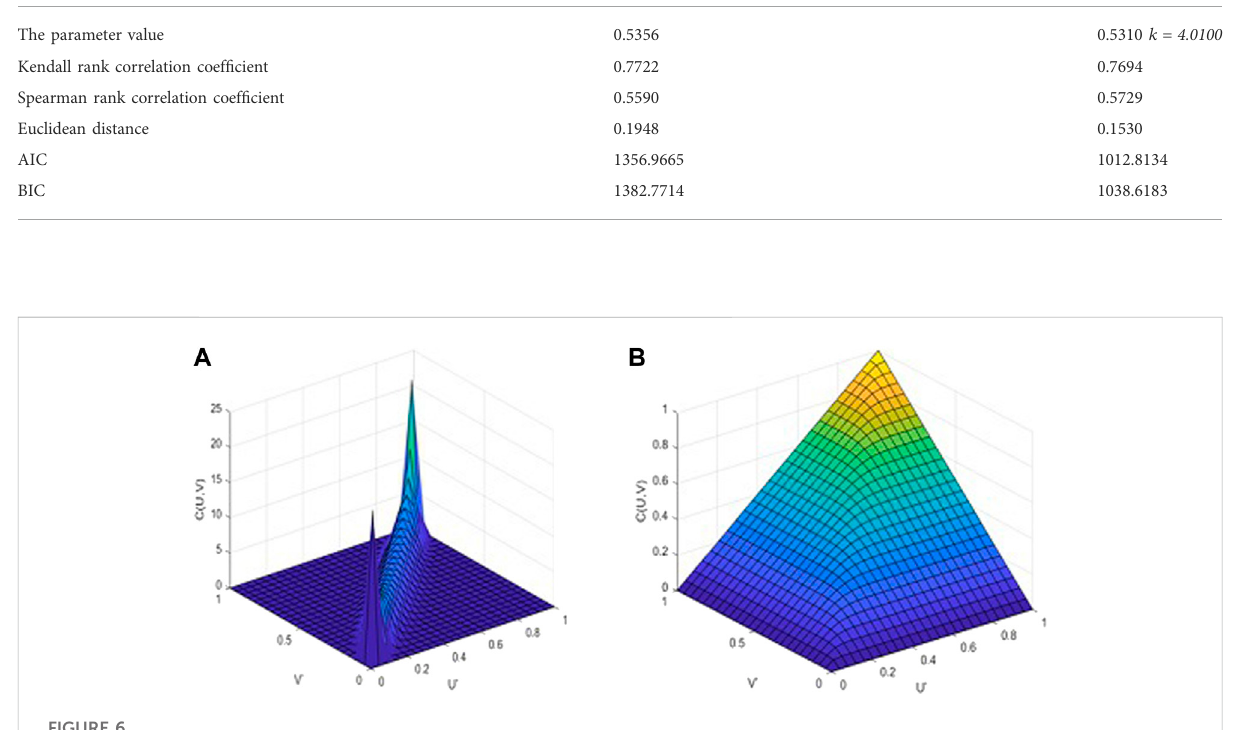
FIGURE 6 Bivariate density function and bivariate distribution fuction of the t-Copula function (A) bivariate t-Copula density function, (B) Bivariate t- Copula distribution